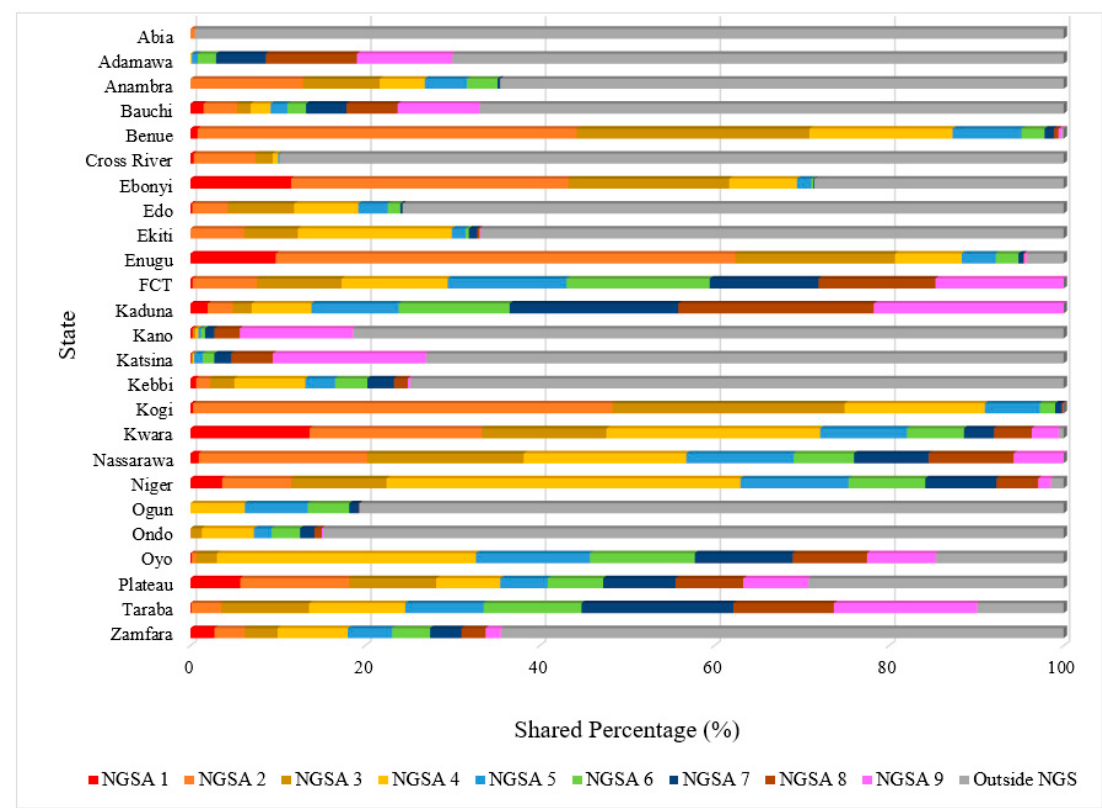
Figure 8. Share of LD archetypes by states in the NGS. Note: shares outside the NGS, that were not analyzed, are in grey. (For full percentages, see supplementary material, Table S2).